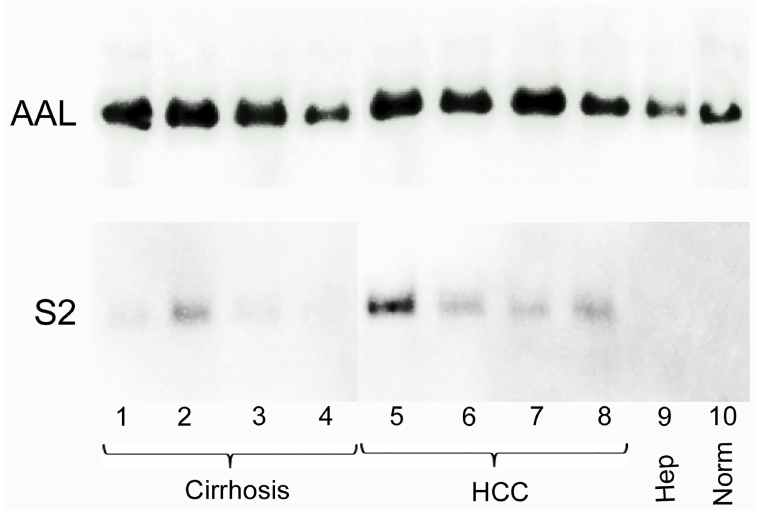
Fig 1. Western blot of AAL and S2 enriched α 1-acid glycoprotein (AGP) from patient plasma samples. Lanes1–4 represent cirrhosissamples, lanes 5–8 HCC samples, lane 9 a hepatitissample and lane 10 a normalplasma sample. AGP was detected using the anti-humanAGP antibody